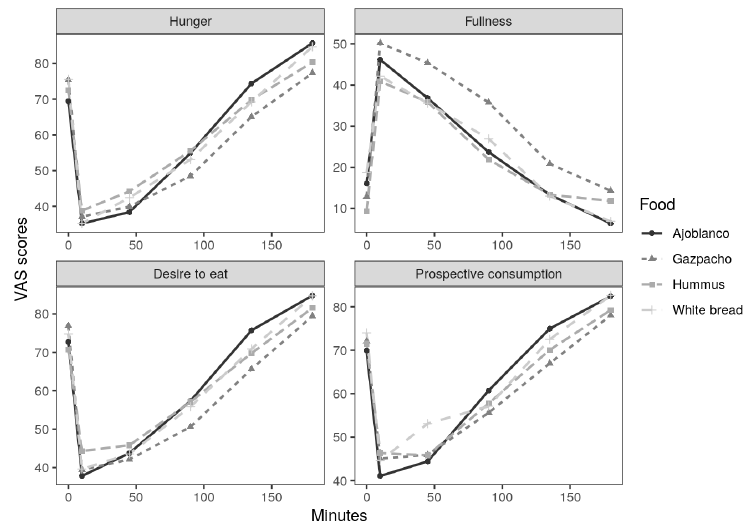
Figure 2. Subjective appetite scores after the four preloads test. Data are presented as mean values ( n = 24).